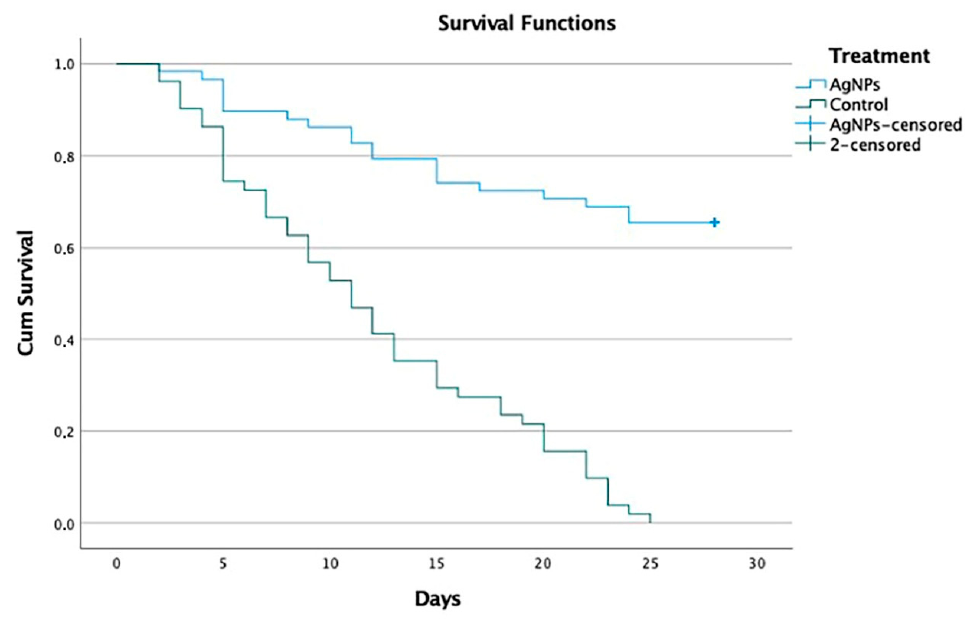
Figure 2. Comparison of survival rates between Groups 2a and 2b. In group 2b (experimental), the survival rate was maintained at above 65%, whereas in group 2b (control), the curve considerably declined, with a survival rate of 0% on day 25.